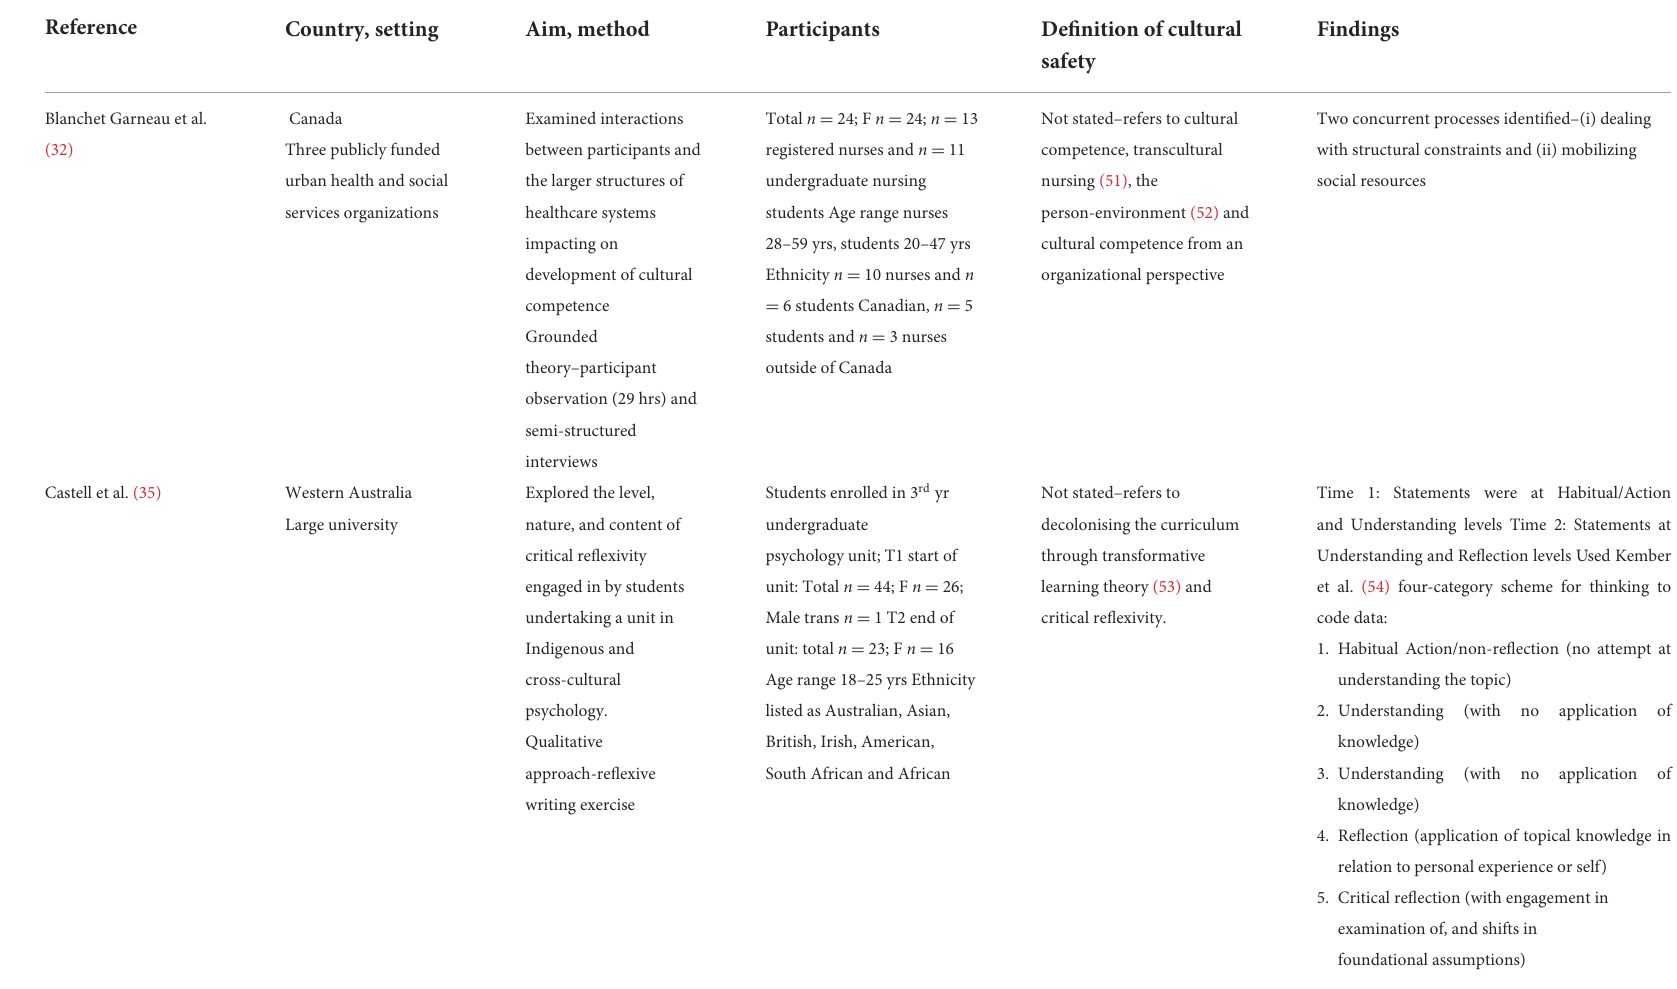
TABLE 2 Summary of included studies by author, year, country, setting, aim, method, participants, cultural safety definition and